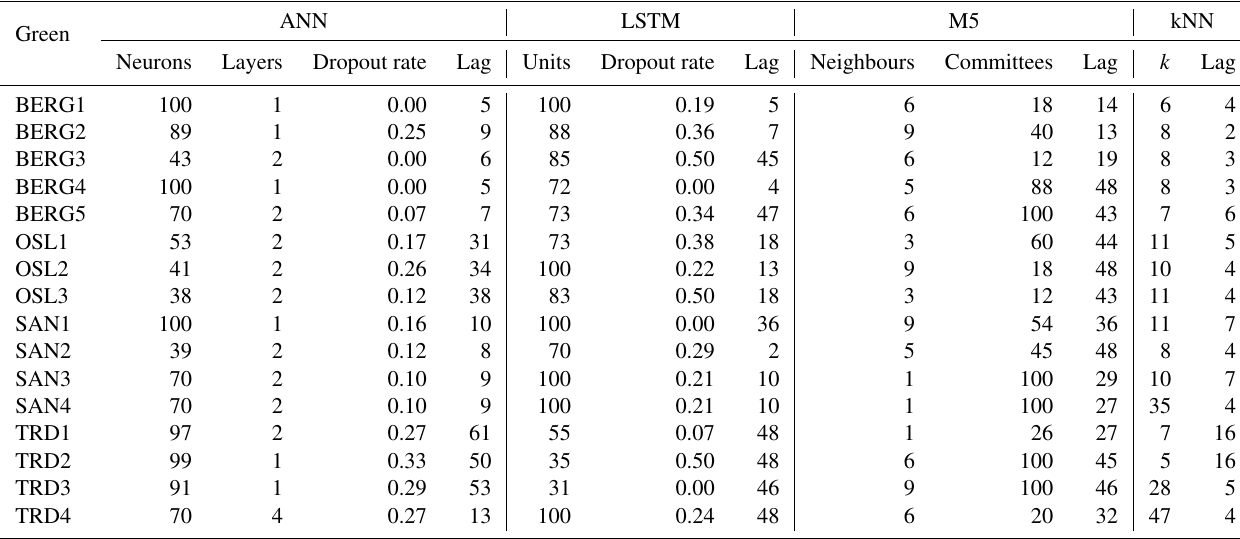
Table 4. Results of ML hyperparameter tuning.